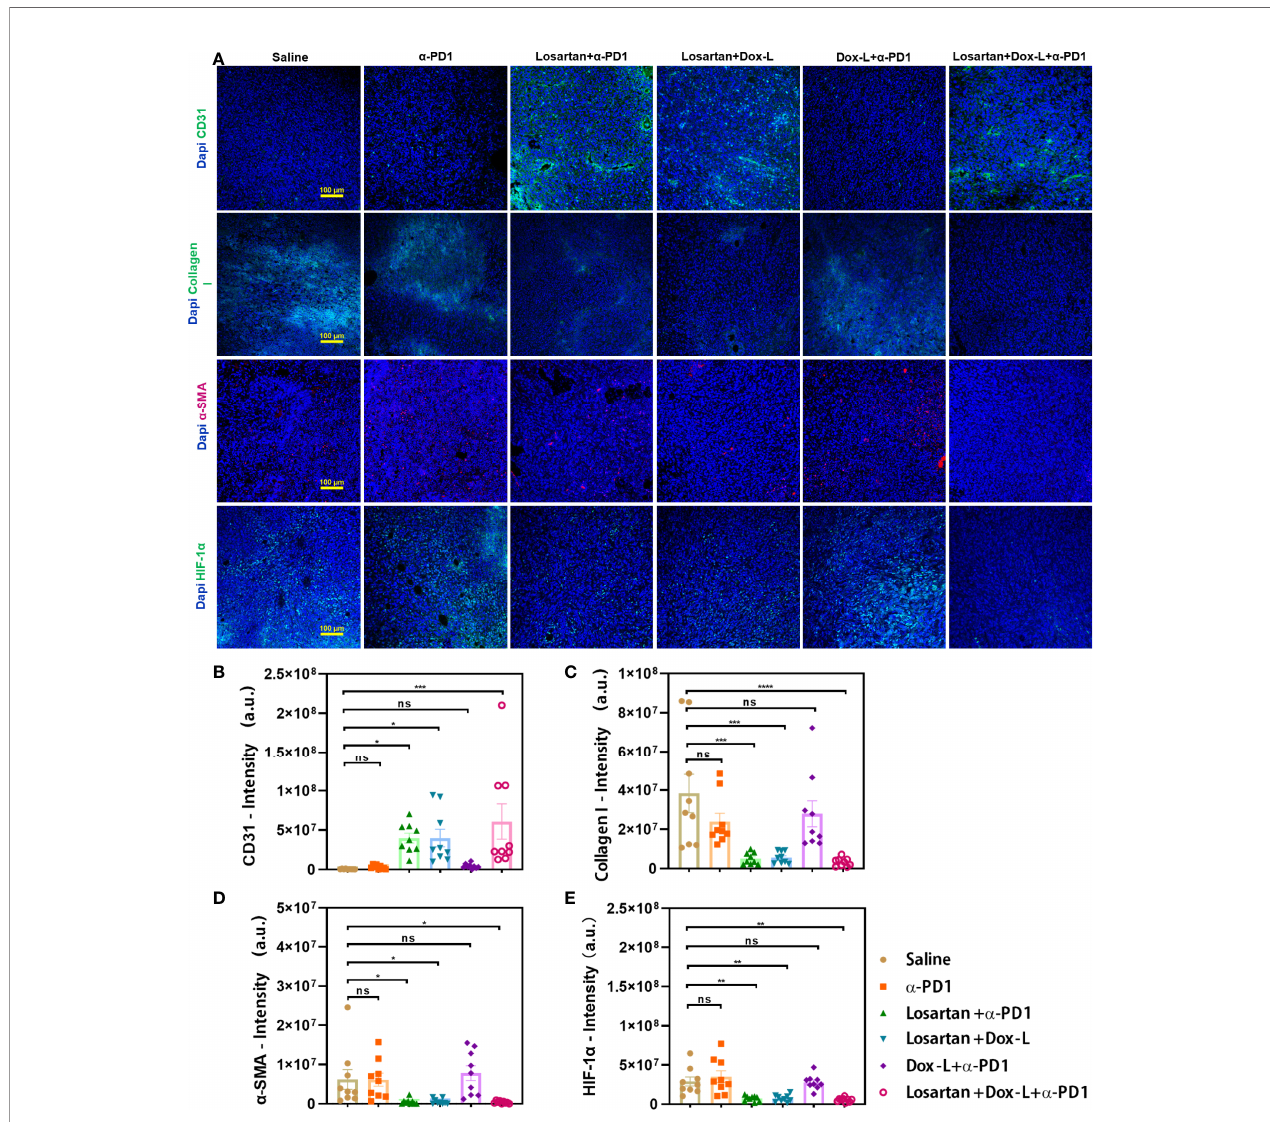
FIGURE 3 | Enhanced tumor normalization by losartan relieves dense tumor stroma, increasing perfusion and alleviating tumor hypoxia. (A) Representative images of CD31 (endothelial marker, green), Collagen I (stroma content, green), a -SMA (pericyte marker, red), HIF-1 a (hypoxia marker, green) immuno fl uorescence staining and DAPI (blue) nuclear staining after various treatments as indicated. Quanti fi cation of CD31 (B) , Collagen I (C) , a -SMA (D) , HIF-1 a (E) positive staining signals from the images shown in (A) . Scale bar = 100 m m. Data are expressed as the mean ± SEM. Statistical signi fi cances were calculated via one-way ANOVA, * p < 0.05, ** p < 0.01, *** p < 0.001 (n = 9). **** p < 0.0001. ns, no signi fi